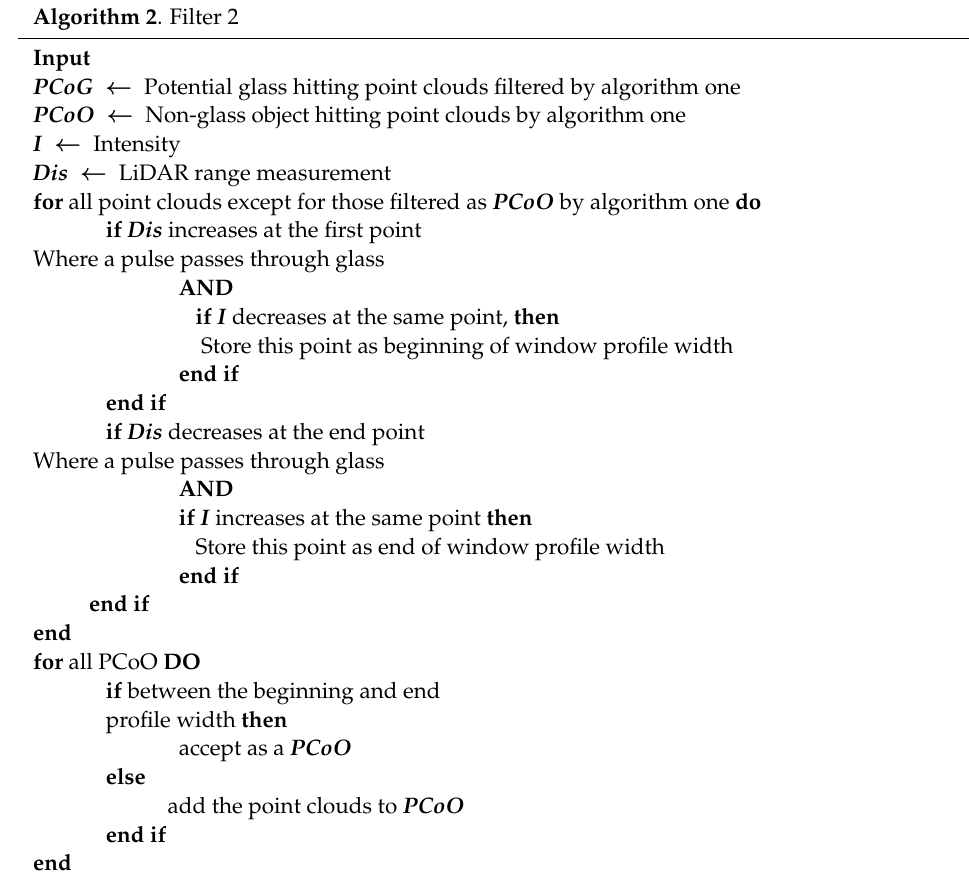
Figure 6. Intensity map from LiDAR (light detection and ranging) sensor. Intensity lowers when distance increases (in other words, the intensity lowers when a laser beam passes through the glass due to the increase in distance).